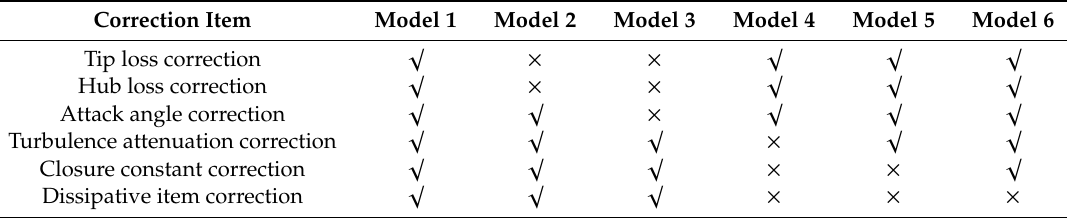
Table 3. Six models for